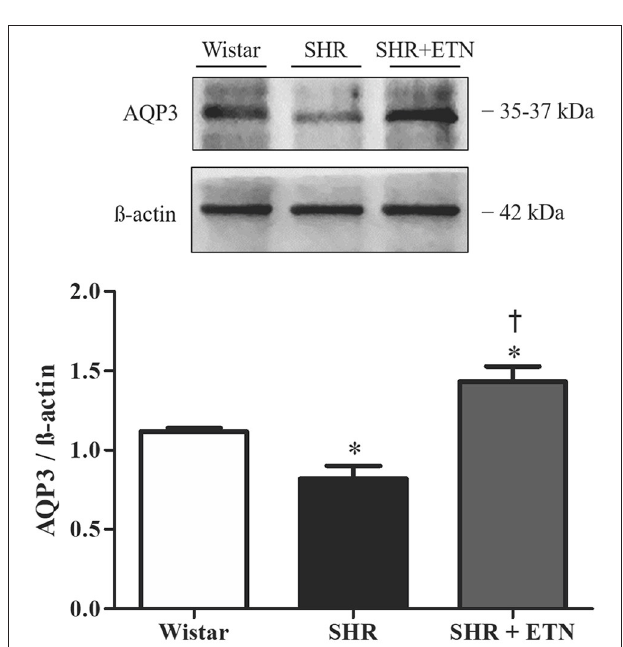
FIGURE 2 | Placental aquaporin 3 (AQP3) expression is decreased in spontaneously hypertensive rats (SHRs) compared to Wistar rats, and etanercept treatment ameliorates SHR AQP3 expression. Upper representative picture of Western blot membrane with the respective AQP3 molecular weight. Bar graph showing the AQP3 expression in placentas from SHR, Wistar, and SHR treated with etanercept (ETN) after normalization to β -actin expression; n = 5. Values are presented as means ± SEM, and data were analyzed by one-way ANOVA, followed by Tukey posttest. * p < 0.05 vs. Wistar; † p < 0.05 vs.